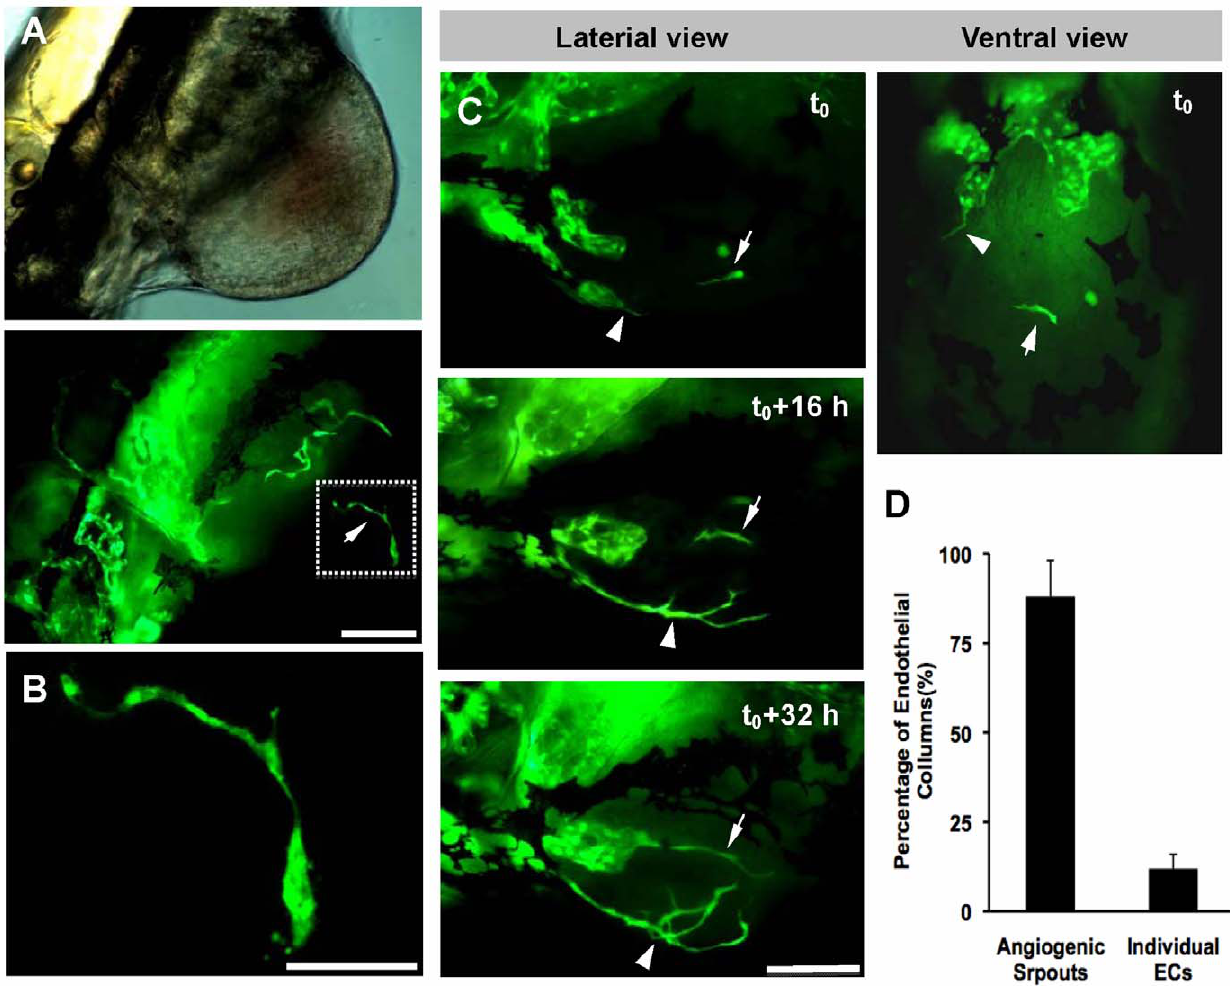
Figure 3. The participation of individual VEGFR2 + endothelial cells to the initial formation of tumor vascular network. Individual VEGFR2 + endothelial cells located at the center of B16 xenograft (indicated by arrow, A). The region in white dotted box was magnified in B. With the tumor growth (C), individual endothelial cells (arrows) increased its length and fused with angiogenic sprouts (arrowheads). (D) Histogram represents (n=12, p , 0.05) the percentage of endothelial columns that originated from the individual ECs or the angiogenic sprouts. Scale bar, 100 m m (A, C) or 50 m m (B).